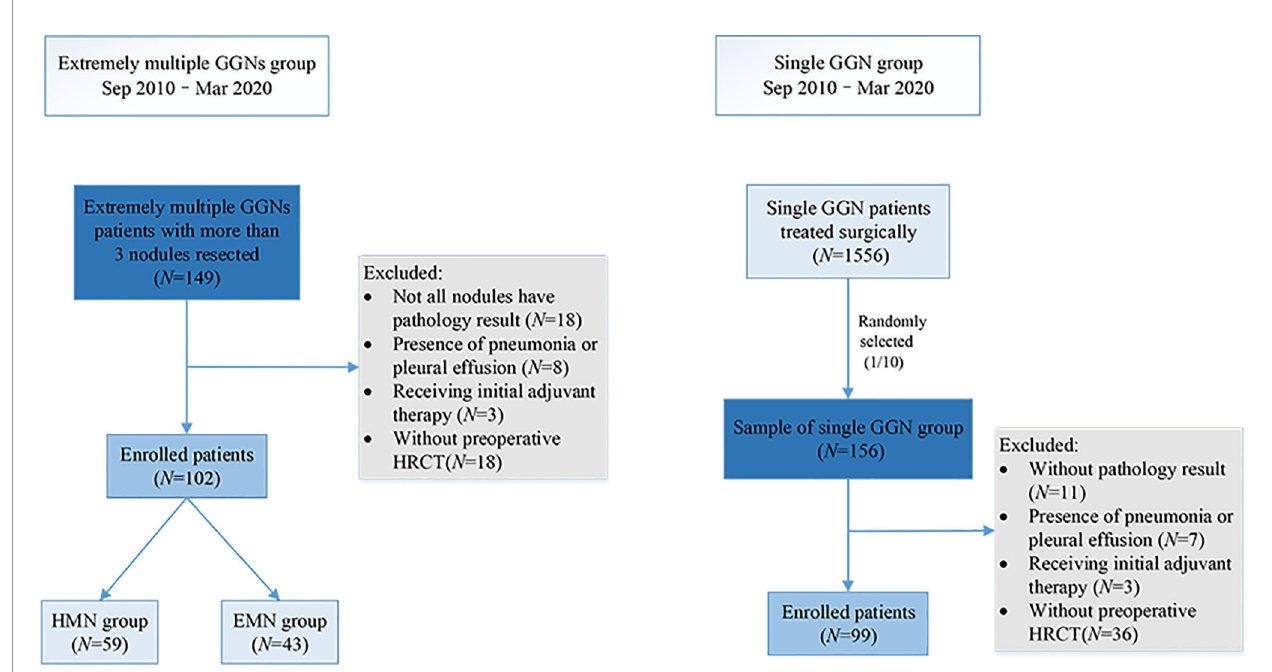
FIGURE 1 | Enrollment fl ow chart of the